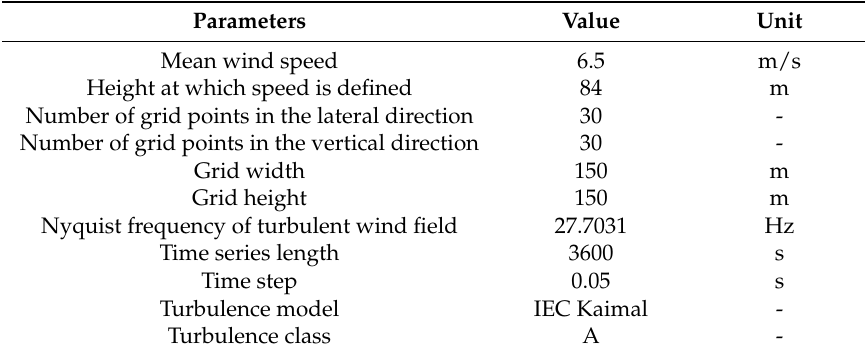
Table 3. Parameters for generating 3D turbulent wind.